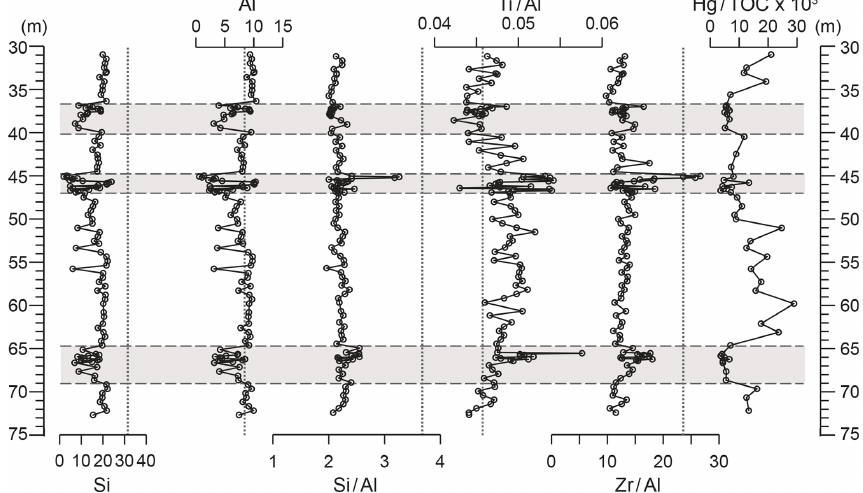
Figure 6. Depth plots of Al and Si concentrations, element / aluminium ratios, and Hg / TOC. Si (%), Al (%), Si / Al (% / %), Ti / Al (% / %), Zr / Al (ppm / %), and Hg / TOC (ppm / %). Grey panels depict the higher-variability mudstone intervals (HVMIs) defined in this study. Vertical dashed lines represent upper continental crust (UCC) reference